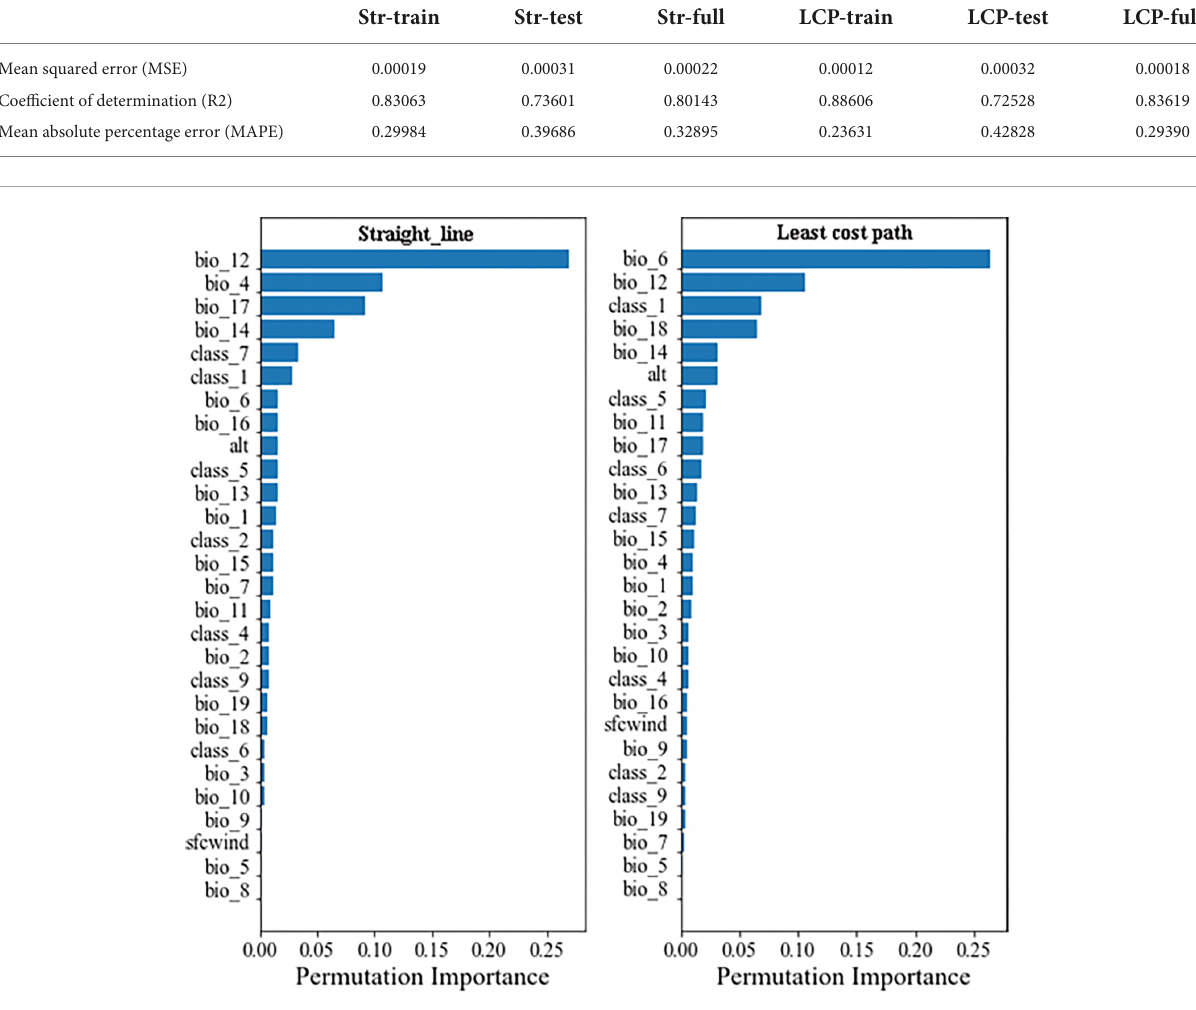
FIGURE5 Permutation feature the importance of the straight-line-based and LCP-based XGBoost-RFR model. The X -axis represents the permutation importance score for each environmental factor.